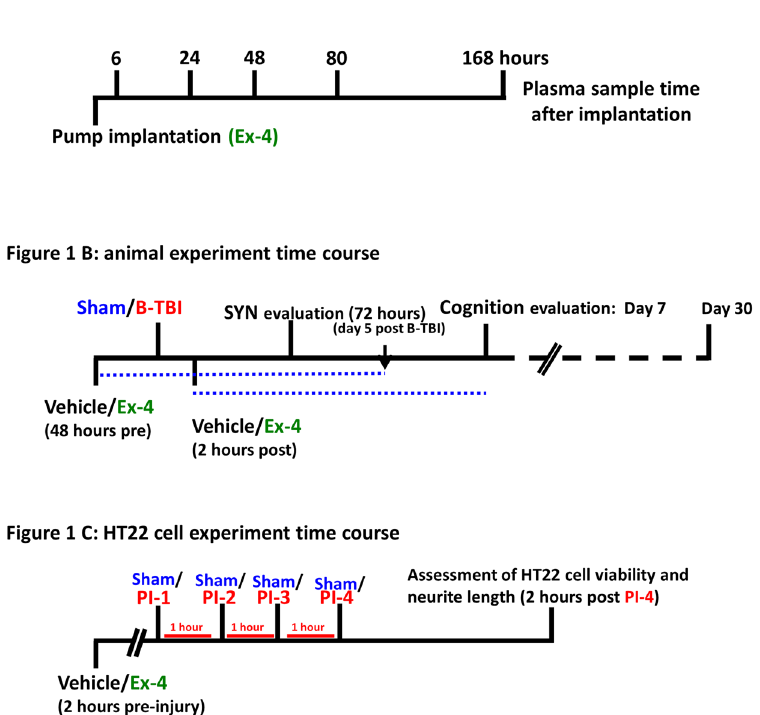
Figure 1. Schema of animal and cell culture study design. Panel A: Plasma was prepared from animals at the indicated times after the surgical implantation of the micro-osmotic pumps containing Ex-4. The levels of plasma Ex-4 were detected using a sensitive ELISA specific for Ex-4. Panel B: Animals were implanted with micro-osmotic pumps containing Ex-4 either 48 hours before or 2 hours after induction of a mild blast TBI (B- TBI). Brain synaptophysin staining studies were undertaken 72 hours after B-TBI. Animal cognition studies were undertaken 7 and 30 days after B-TBI. The blue dotted line indicates the duration of Ex-4 infusion by the 7 day micro-osmotic pumps. Panel C: HT22 cells were subjected to a series of sham or pulse injury (PI) procedures. Cells were pre-treated with drug vehicle or Ex-4 (25 nM or 100 nM) 2 hours prior to sham or PI challenge. Two hours after the last sham or PI challenge assessments of cell viability and neurite length were undertaken.